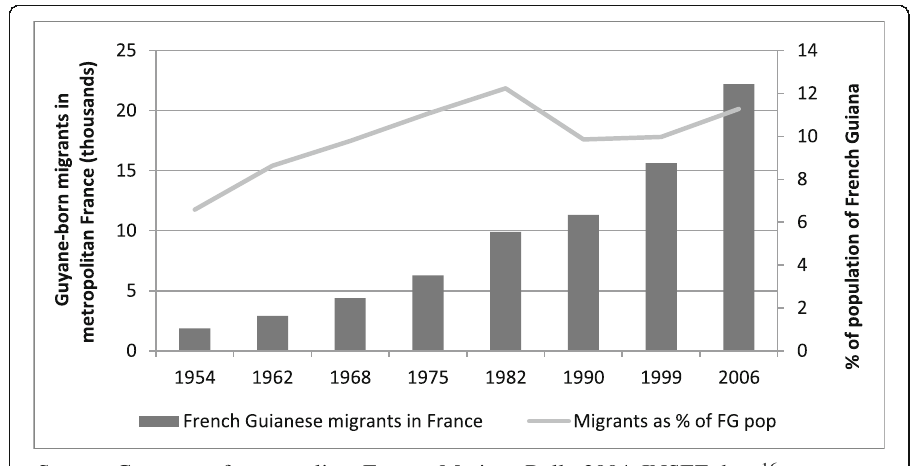
Fig. 6 French Guiana-born population in metropolitan France, 1954 – 200619 (Marie et Rallu 2004)